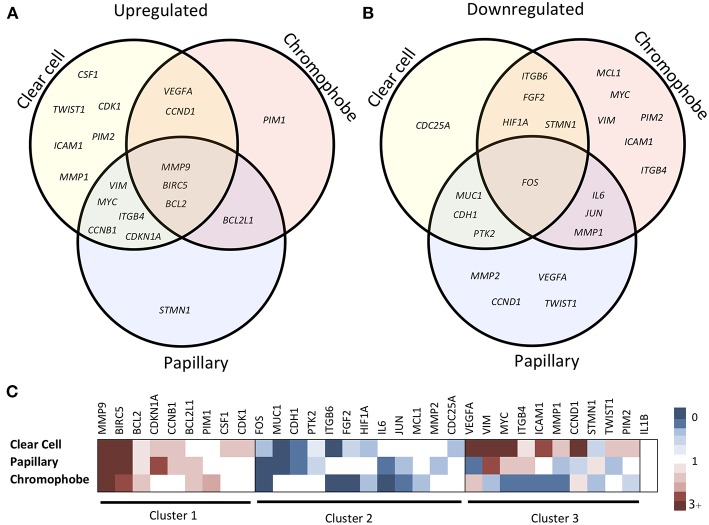
Comparison of STAT3-regulated gene expression changes in three RCC subtypes. Venn diagram showing significantly upregulated (A) and downregulated (B) genes across clear cell, papillary and chromophobe renal cancer subtypes. Heatmap (C) shows gene expression fold change values in tumor as compared to unmatched adjacent normal. Red color represents increased expression, blue represents decreased expression and white represents no significant change.